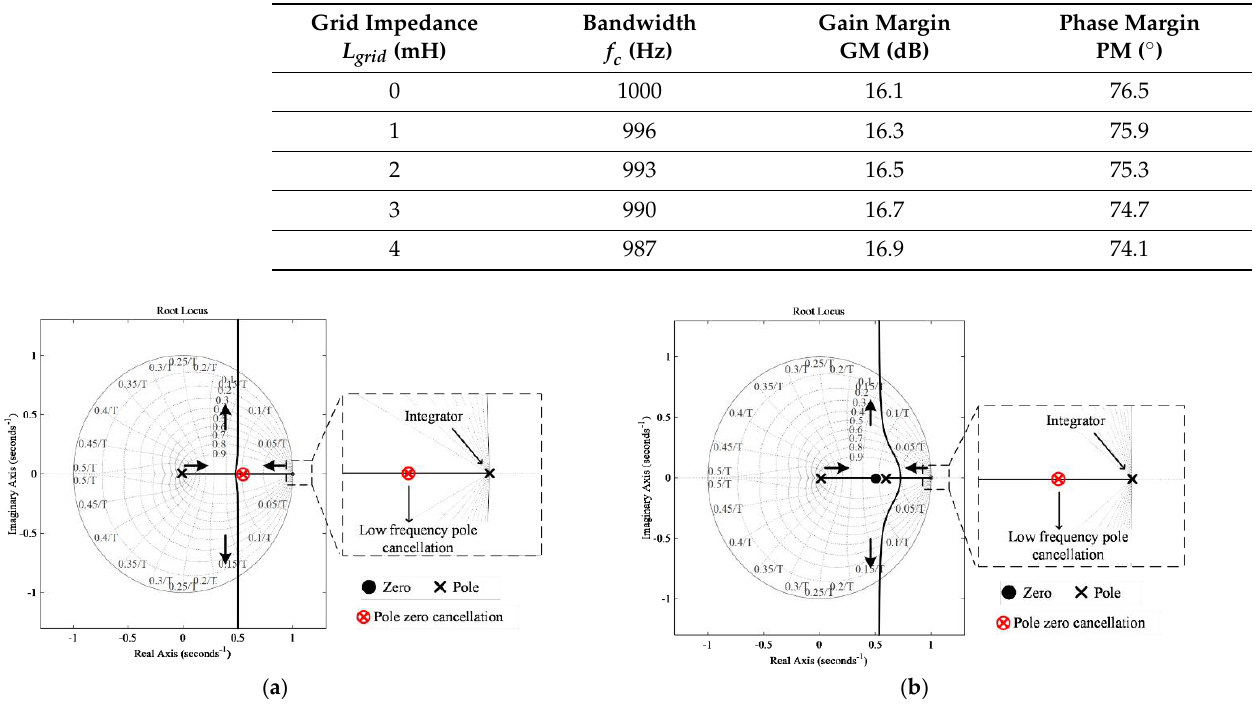
Figure 14. Root locus of loop gain transfer function for L filter type GcI with RESO-based ADRC: ( a ) For L grid = 0; ( b ) For L grid = 4mH.